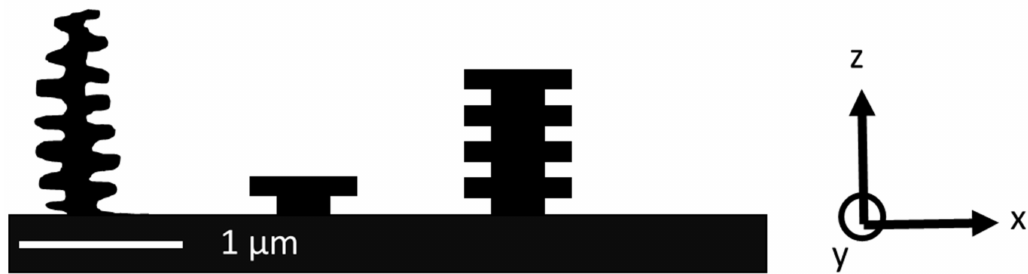
Figure 1. Left: sketch of the cross-section of the nanostructures responsible for the metallic-blue color of the Morpho butterfly. The sketch was created after images found, e.g., in [12,33]. Center and right: model structures used in this work. We started with a single layer “T-structure” and continued to work with the more complex